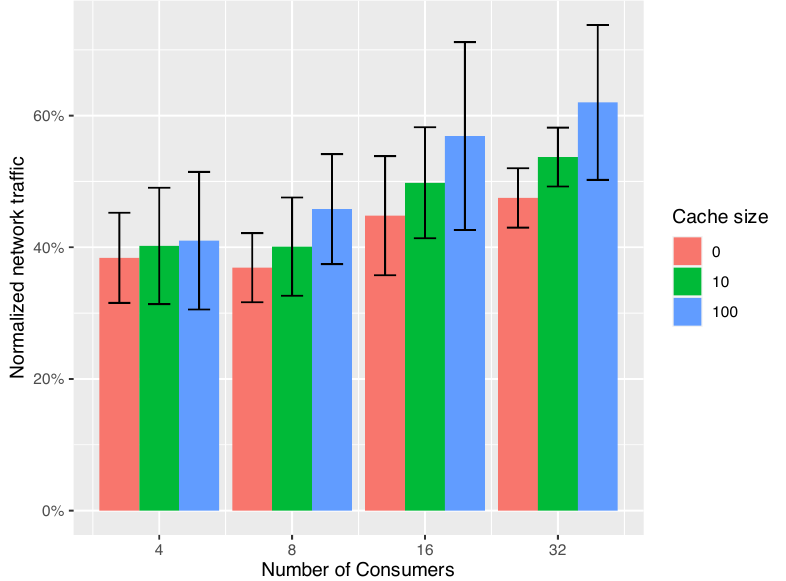
Figure 7. Total amount of data exchanged (normalized) through the network when a set of consumers requests the same content from a producer at their maximum attainable rate for different cache